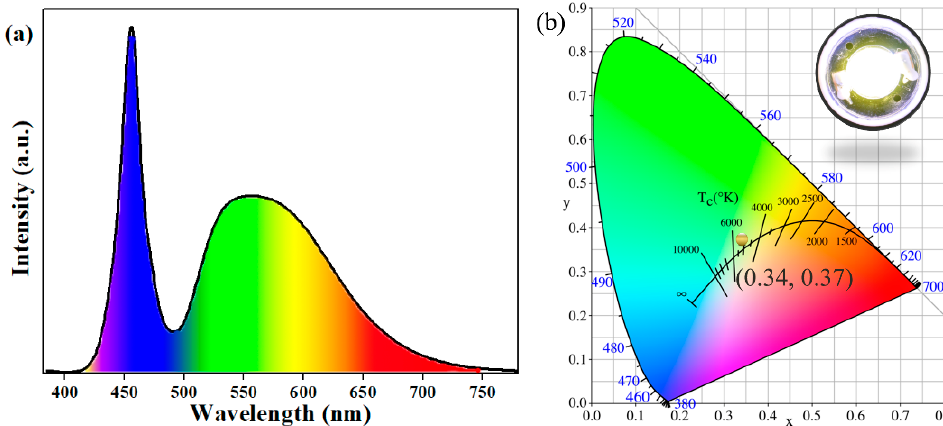
Figure 8. ( a ) The EL spectrum of the PiG-based white LED at an operating current of 350 mA. ( b ) The CIE chromaticity diagram and a digital photograph of the PiG-based LED in operation. CIE chromaticity diagram and a digital photograph of the PiG-based LED in